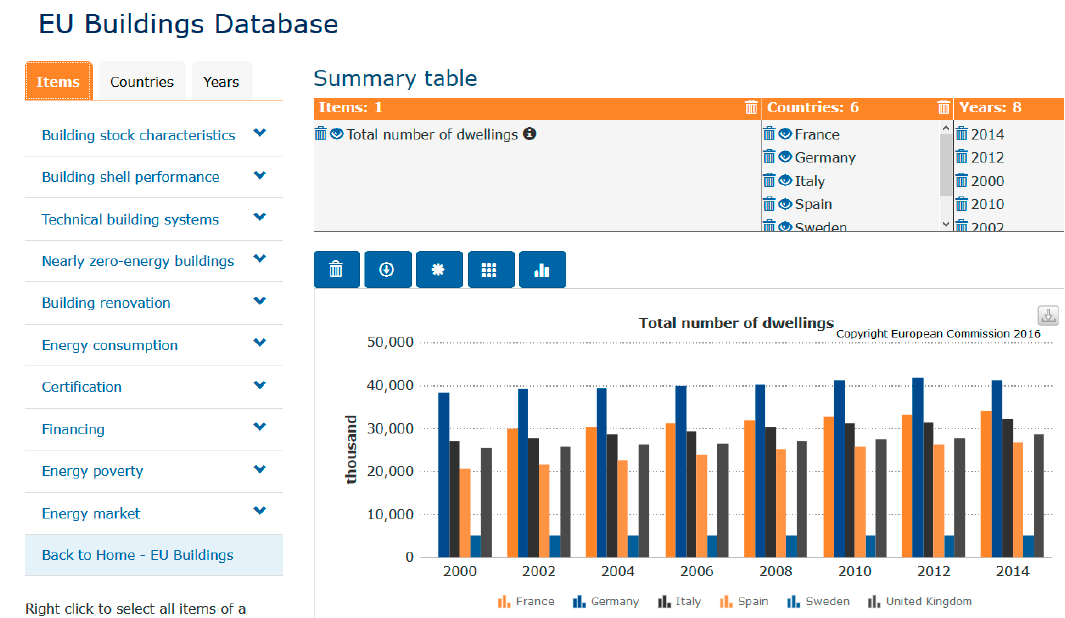
Figure 2. European Union (EU) Building Stock Observatory database interface [18].